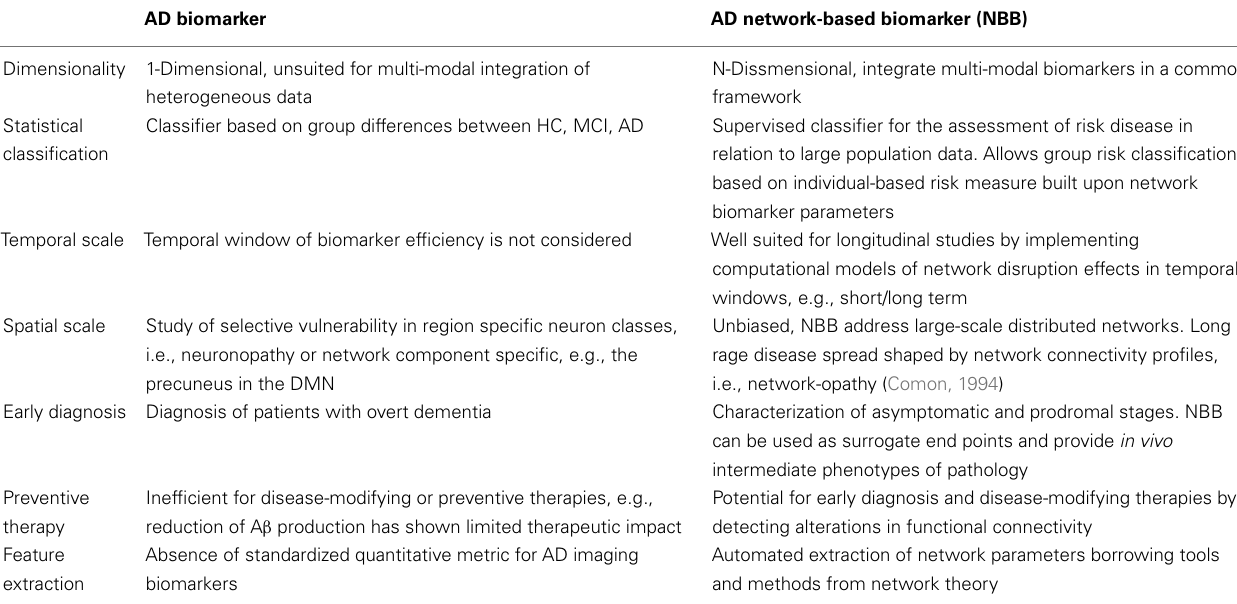
Table 1 | Differences between the standard and the network-basedAD biomarker approaches